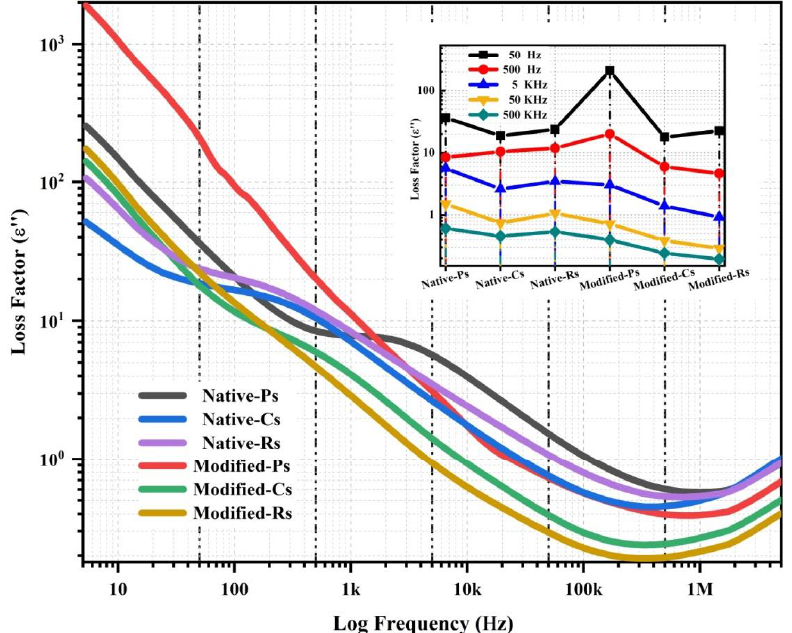
Figure 2. Frequency dependence of loss factor of native form and modified form of starches over the log frequency.